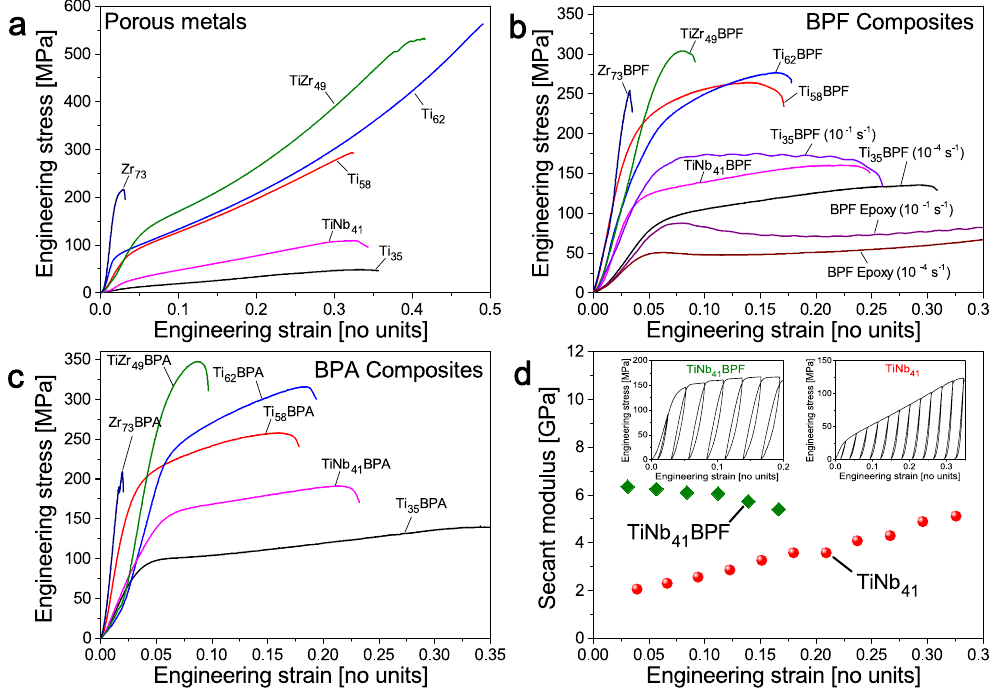
Figure 2. Mechanical behavior of porous metals and composites, probed by compression tests. Strain rates are 10 − 4 s − 1 unless otherwise indicated. ( a ) Porous metals, compressive stress-strain curves. ( b ) BPF-based composites, compressive stress-strain curve. Note strain-rate sensitivity of strength, as exemplified by the data for Ti 35 BPF. Also shown is data for pure BPF samples (no metal) of similar geometry, illustrating the strain-rate sensitivity of the epoxy. ( c ) BPA-based composites, compressive stress-strain curves. ( d ) Composites TiNb 41 and TiNb 41 BPF, secant modulus plotted against engineering strain for composite (inset: loading-unloading stress- strain curves for TiNb 41 BPF (left) and TiNb 41